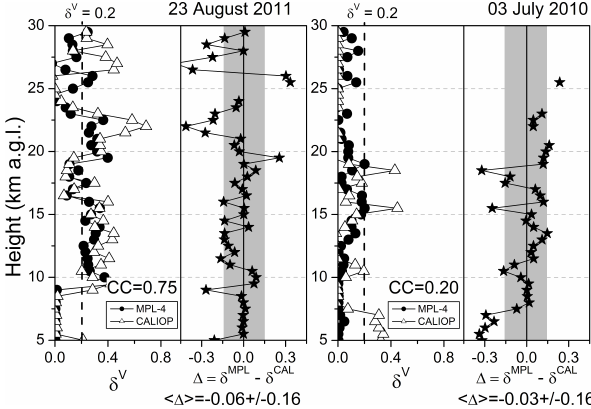
Fig. 8. Simultaneous 0.5-km averaged profiles of the volume linear depolarization ratio δ V for MPL-4 (full circles) and CALIOP (open triangles), and the differences 1 = δ MPL − δ CAL (black stars) found between both lidar δ V profiles for CALIPSO ground-track distances < 10km (D1 distance range) from Belgrano II station. PSC events correspond to those cases with a high/moderate and low CC values as observed, respectively, on 1 July 2009 (left) and 25 Septem- ber 2009 (right). A height-averaged 1 value ( <1> ± SD) is also shown in each case.